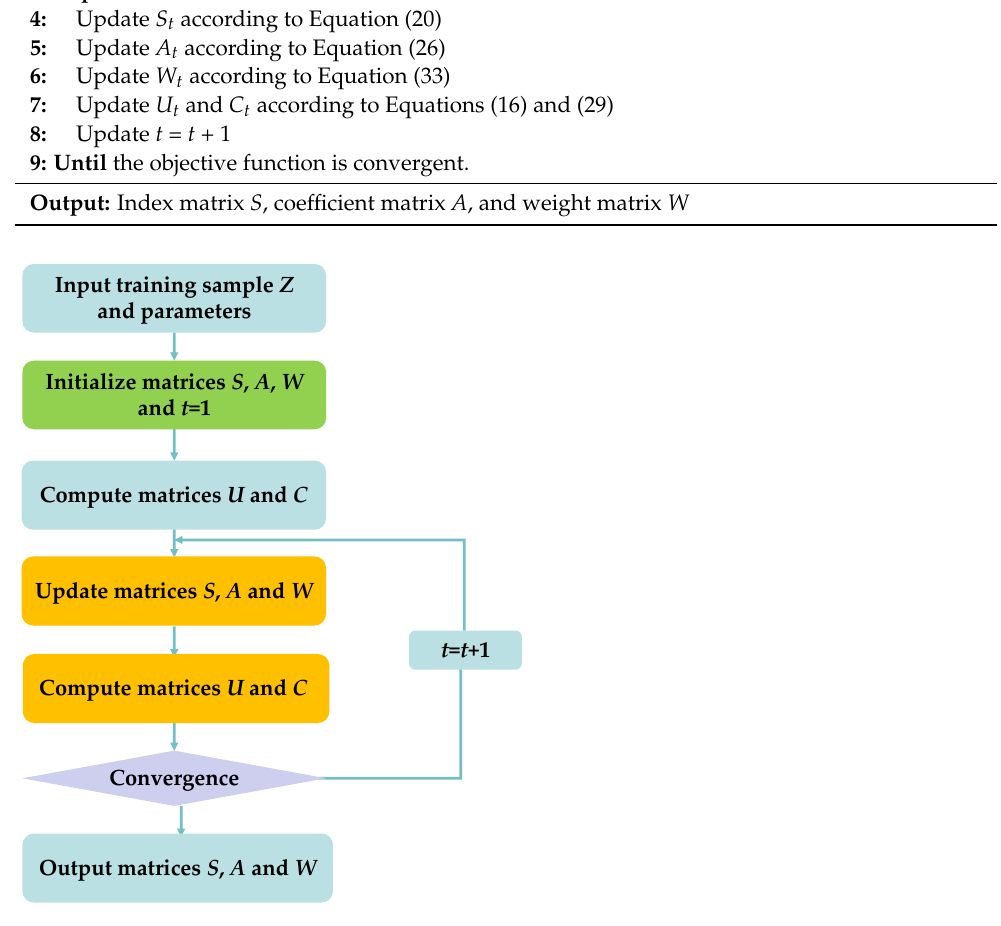
Figure 2. The flowchart of the proposed RMFRASL method.